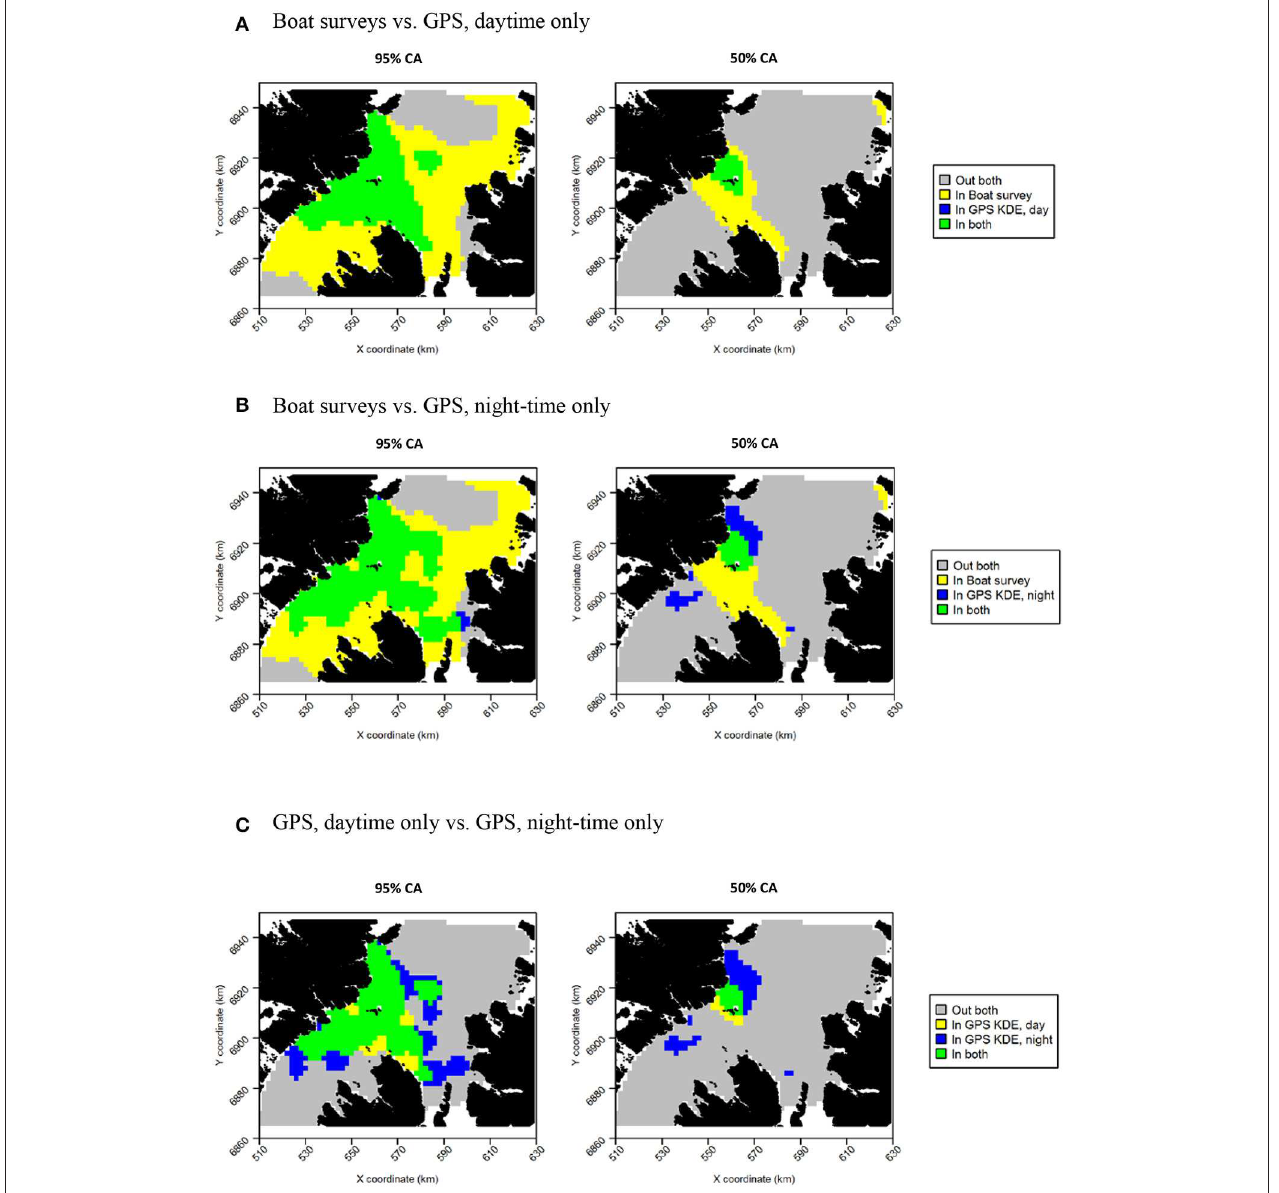
FIGURE 10 | Overlap between razorbill core areas (CAs) derived from boat surveys, GPS tracking in daytime and GPS tracking at night-time. In all maps, gray indicates areas outside of the CA in both data sources, and green indicates areas inside the CA in both data sources; blue and yellow indicate areas in the CA in one data source but not the other. (A) Boat surveys vs. GPS, daytime only. (B) Boat surveys vs. GPS, night-time only. (C) GPS, daytime only vs. GPS, night-time